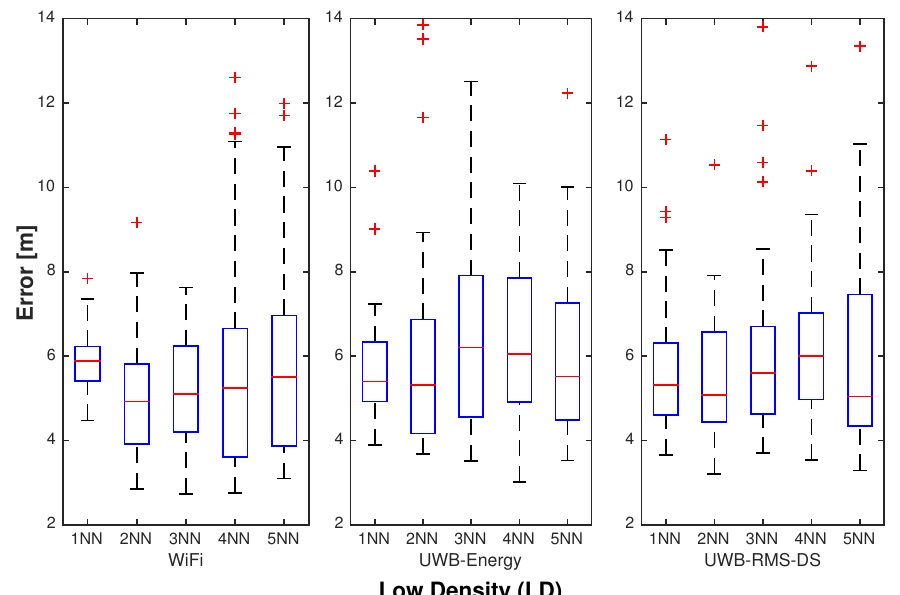
Figure 3. Statistics of positioning error (cid:101) in low density (LD) scenario for WiFi, ultra-wideband (UWB)-energy and UWB root-mean-square delay spread (RMS-DS) with fixed k -nearest neighbor ( k NN) algorithm ( k = { 1,2,3,4,5 }